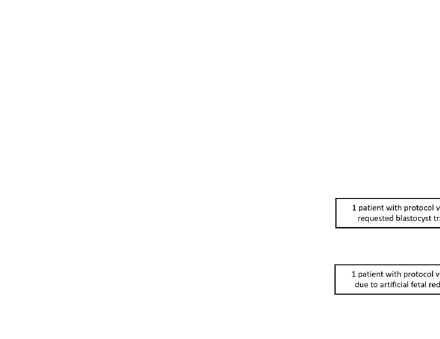
FIGURE 1 | CONSORT diagram of participant screening, randomization, and